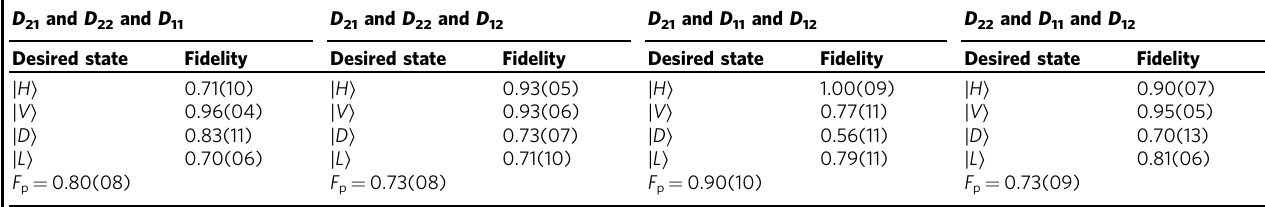
Table 1 Fidelities of the output states to the ideal states and the process fi delities to the ideal teleportation process D D D 21 and 22 and 11